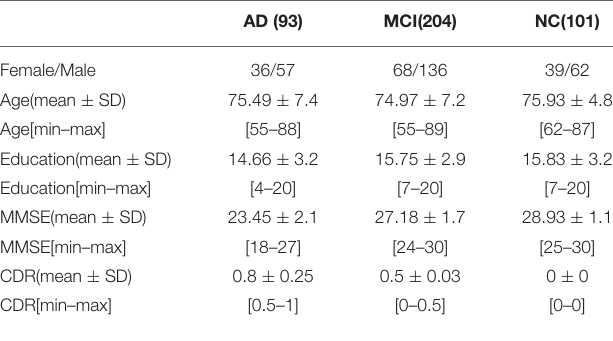
TABLE 1 | Clinical and demographic statistics (SD: standard